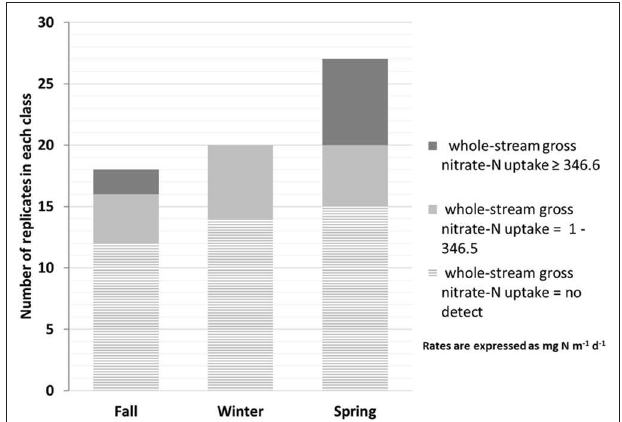
FIGURE 4 | Distribution of whole-reach gross nitrate-N uptake rate measurements by season organized by whole-reach gross NO − 3 -N uptake rate = 0, rate = 1 – 346.5mg N m − 1 d − 1 , and rate ≥ 346.6mg N m − 1 d − 1 , above this rate is considered a “hot moment”) in streams 1–5 from pulse addition experiments. We did not observe measurable whole-reach gross NO − 3 -N uptake rates at site